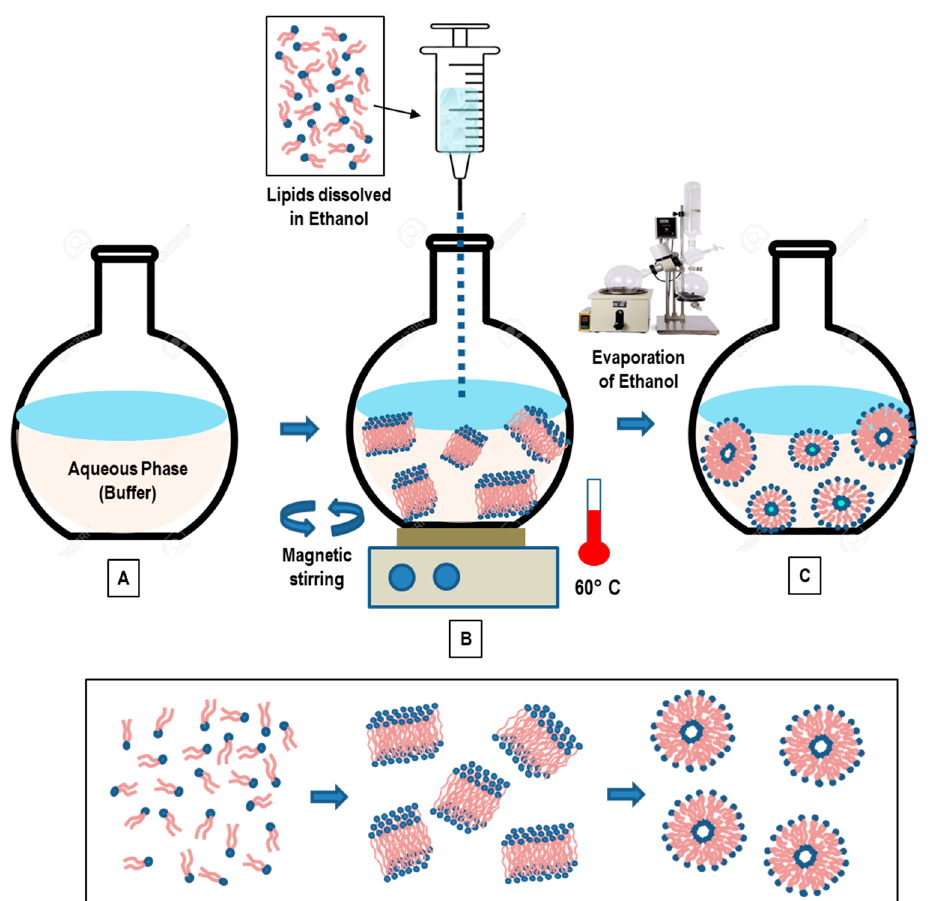
Figure 5. Schematic representation of the main stages of the ethanol injection method. A composi- tion of lipids dissolved in alcohol solution is injected into an aqueous phase (buffer) ( A ). The dilution of ethanol in the water solution favors the self-assembly of lipid components and the formation of bilayer planar fragments ( B ). Finally, the ethanol evaporation (depletion) favors the fusion of the lipids’ fragments and the formation of closed unilamellar vesicles (SUL and LUV) ( C ). The volume of added ethanol represents a crucial factor of the liposome formation.